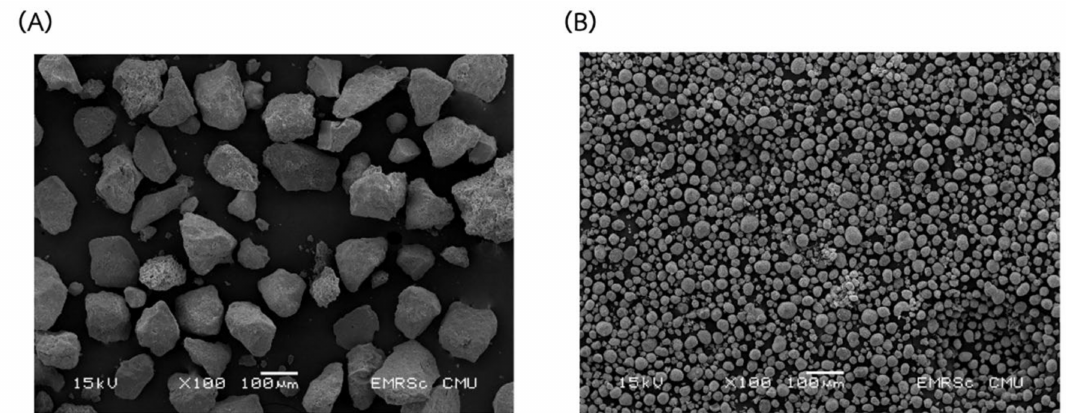
Figure 8. Morphology of extracted ( A ) and commercial hydroxyapatite ( B ) after adsorption of BSA.